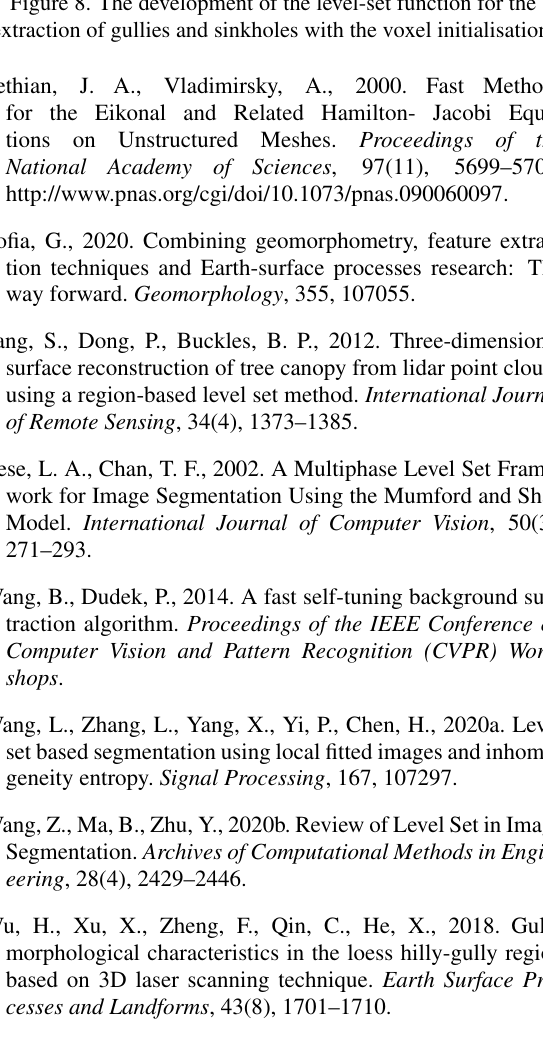
Figure 9. Final 3D extraction of the gullies and sinkholes. The lower figure shows a focused side-view of a set of extracted sinkholes.